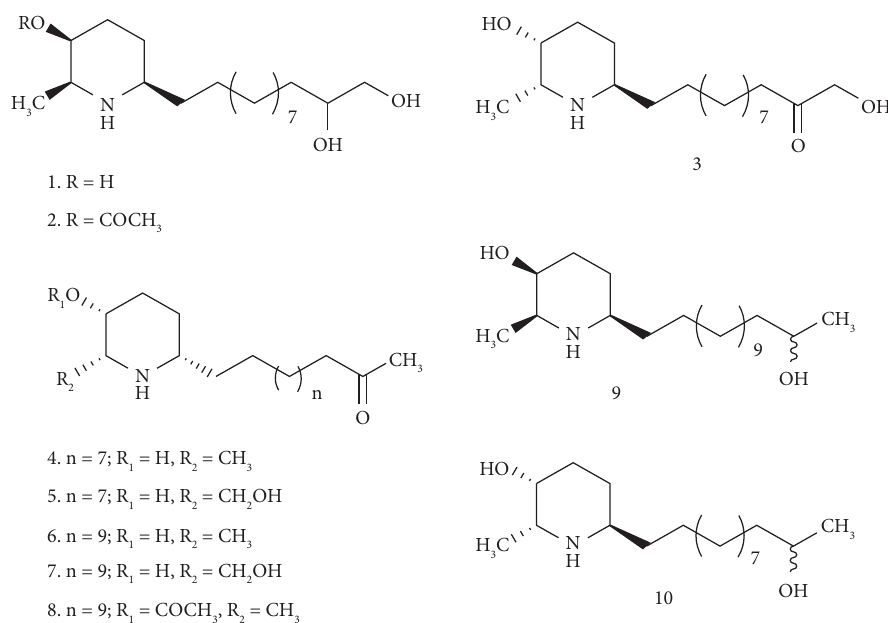
Figure 4: Piperidine alkaloids identifed in the ethanolic and water extracts of C. spectabilis